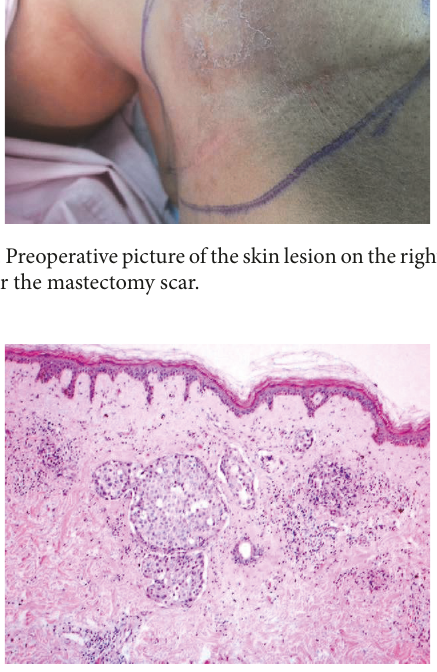
Figure 2: Histopathology of the skin lesion featuring intact epider- mis and several dilated lymphatics or capillaries in the dermis filled with tumor emboli (H&E × 40).